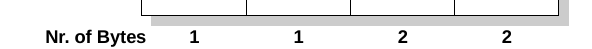
Figure 2. Basic FSoE